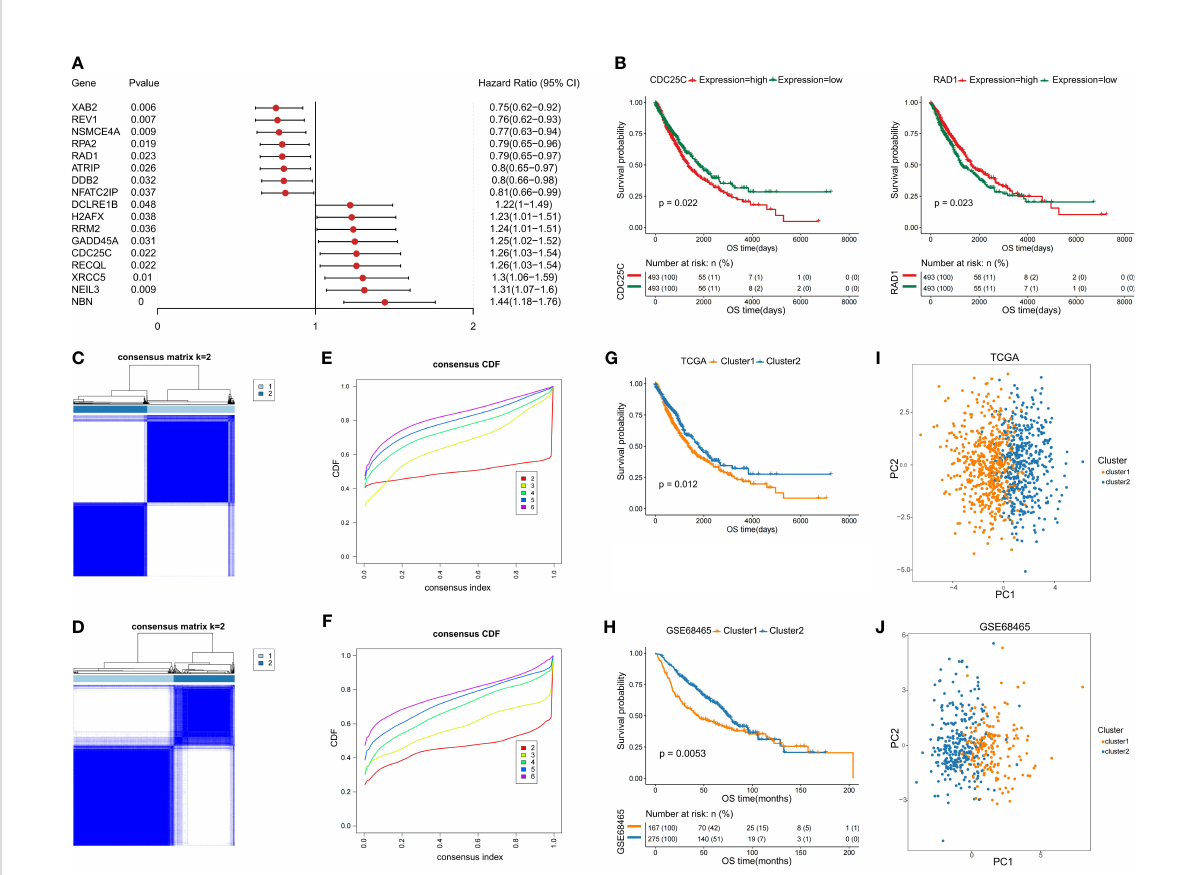
FIGURE 2 Identi fi cation of two NSCLC subclasses based on the prognostic DDR-related genes. (A) Forest map of prognostic DDR-related genes. (B) Kaplan – Meier (KM) survival curves with transcriptomic pro fi le of prognostic DDR-related gene. (C, D) Identi fi cation of NSCLC subclasses with PAC clustering using 17 prognostic DDR-related genes in the training and testing sets. (E, F) The CDF plot shows a fl at middle segment for K = 2 in the training and testing sets. (G, H) OS of both subclasses (C1 and C2) in the training and testing sets. (I, J) PCA showing the distribution of the two NSCLC subclasses in the training and testing